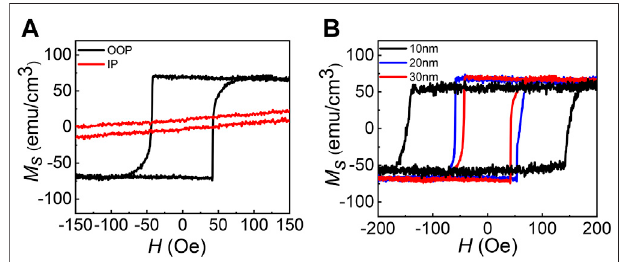
FIGURE4|(A) Out-of-plane (blackline)andin-plane(redline)hysteresis loops of a 30-nm-thick sample in narrow range. (B) Out-of-plane hysteresis loopof10-,20-,and30-nm-thick fi lmsinthenarrowrange.Theparamagnetic contribution from the substrate sGGG has been removed in the raw